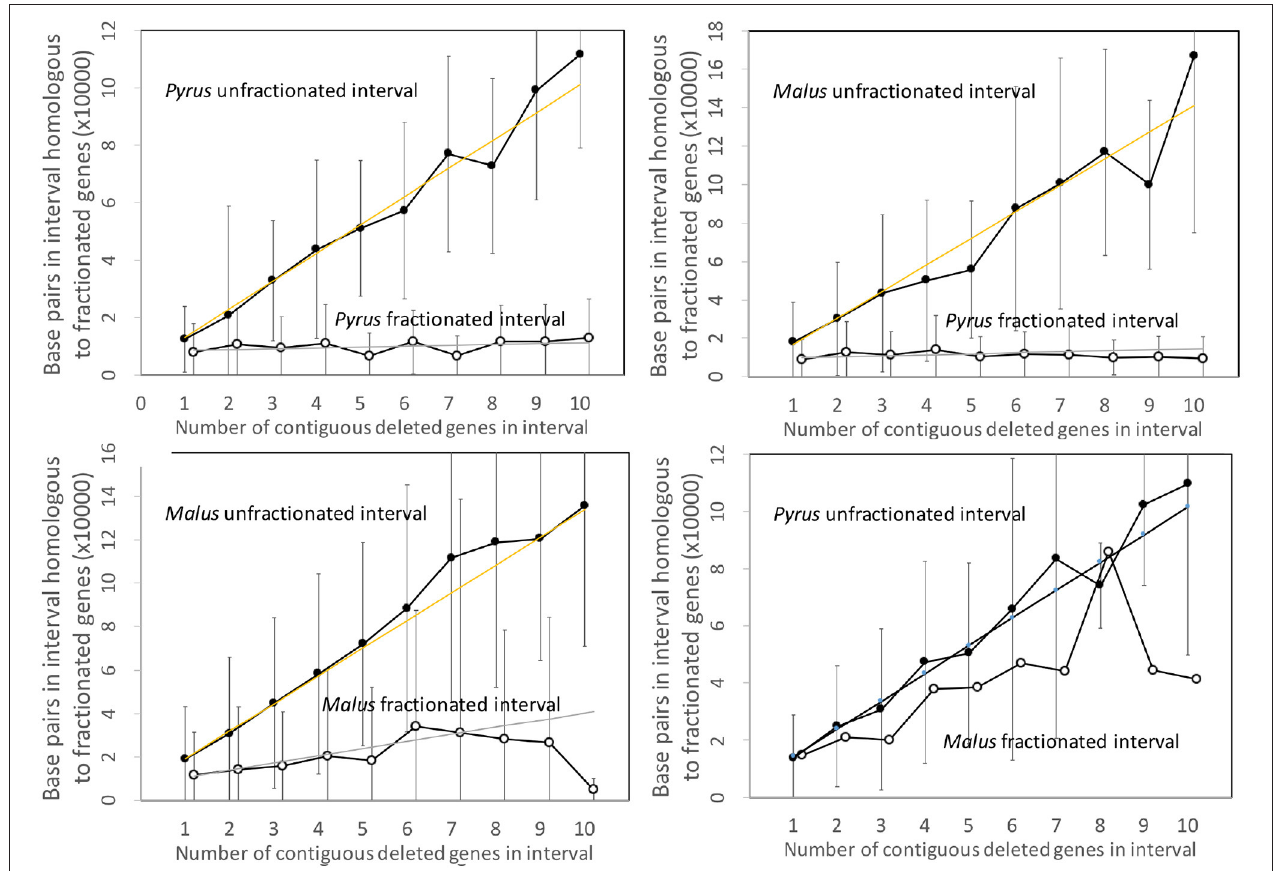
FIGURE 7 | Comparison of DNA content in unfractionated and fractionated (conserved and reduced) intervals in the Pyrus and Malus genomes.